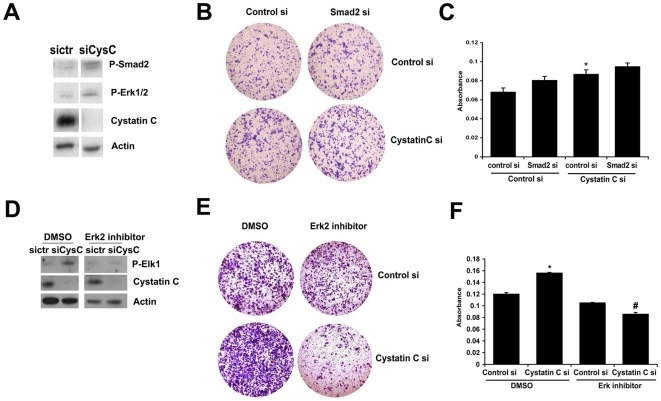
The role of Erk1/2 and Smad2 in cystatin C regulated invasion of PC-3 cells.
A). Immunoblot analysis of P-Smad2 in PC-3 cells after silencing of Smad2. B–C). Invasion assay in PC-3 cells after silencing of Smad2 simultaneously with knockdown of cystatin C. The representative pictures are shown in B and quantitative results of 3 independent experiments are presented in C. *p<0.05 (Student T-test). D). Immunoblot with antibody against phosphorylated (Ser383)-Elk1 and cystatin C in the lysates from PC3 cells transfected transiently with siRNA cystatin C and control siRNA and co-treated with Erk2 inhibitor (25 µM). Note that Erk2 inhibitor blocks downstream phosphorylation of Elk1 a target of Erk2 in cells with knockdown of cystatin C. Data are representative for 2 experiments. E–F). Invasion assay in PC-3 cells after concomitant silencing of cystatin C and inhibition of Erk2 with selective inhibitor. The representative pictures are shown in D and quantitative results of 2 independent experiments are presented in E. *p<0.05, #p<0.01 (Student T-test).